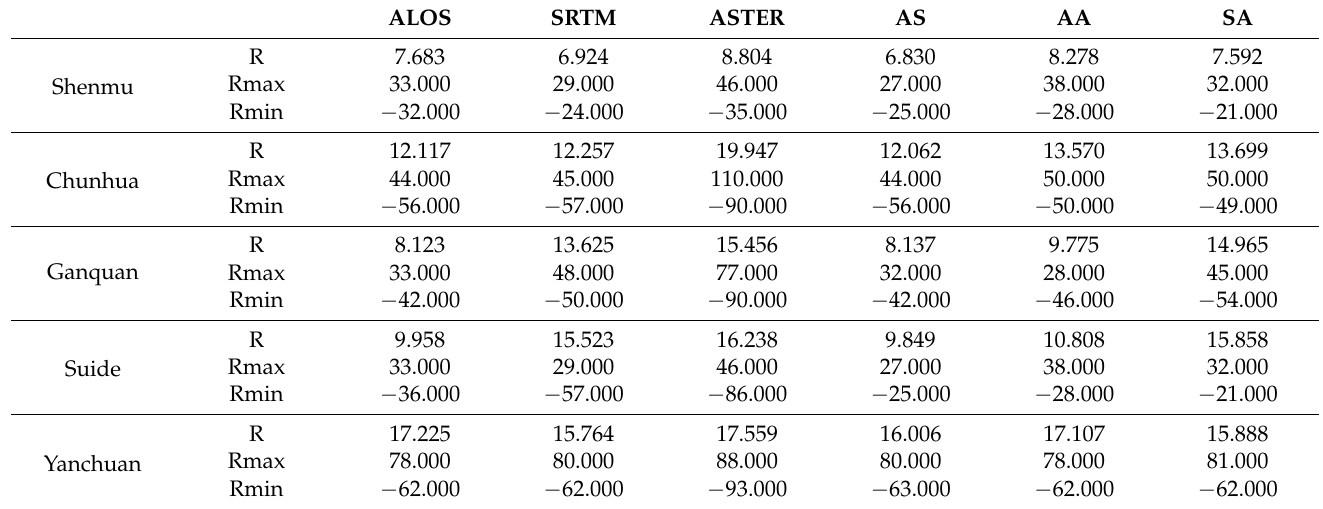
Table 5. Error statistic parameters in different study areas obtained via ENVI GS fusion (unit: m). ALOS SRTM ASTER AS